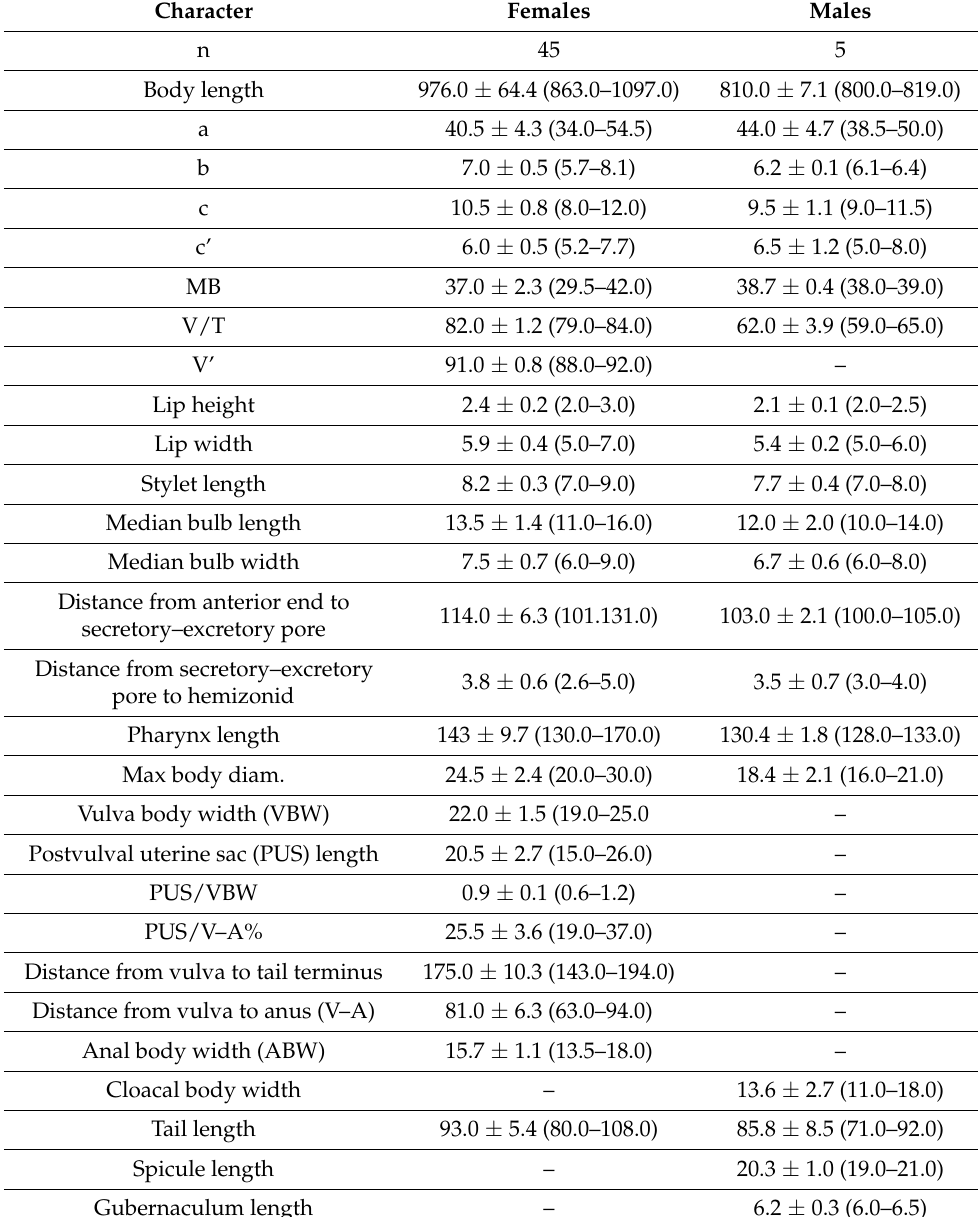
Table 5. Morphometric characteristics of Ditylenchus valveus Thorne and Malek [31] found in this study. All measurements are in µ m and in the form: mean ± standard deviation